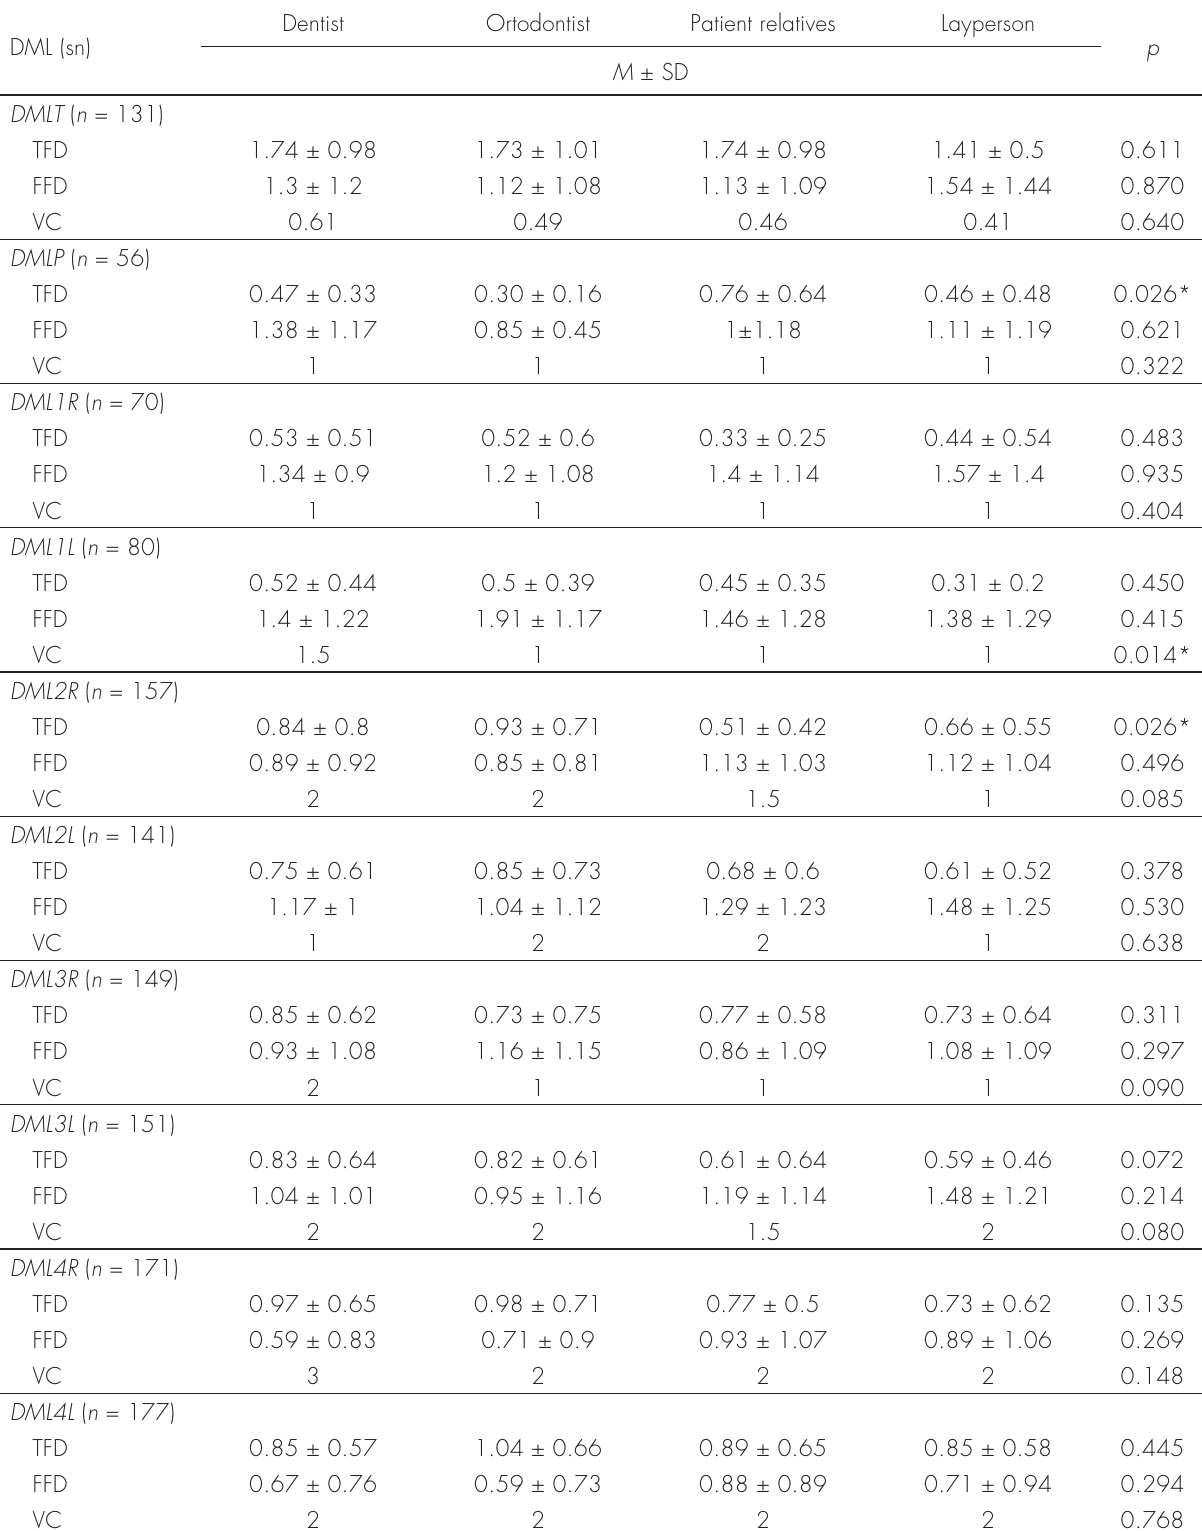
Table I. Fixation values based on occupational